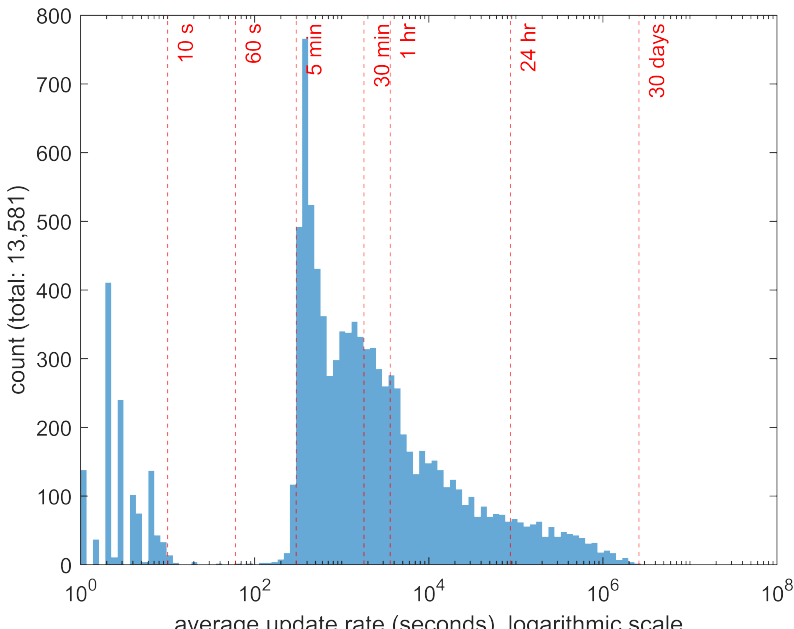
Figure 11. English Channel average reporting interval of the same ship (MMSI), for all ships during October 2017. (Note that ships with a single timestamp are omitted (total: 3123).)